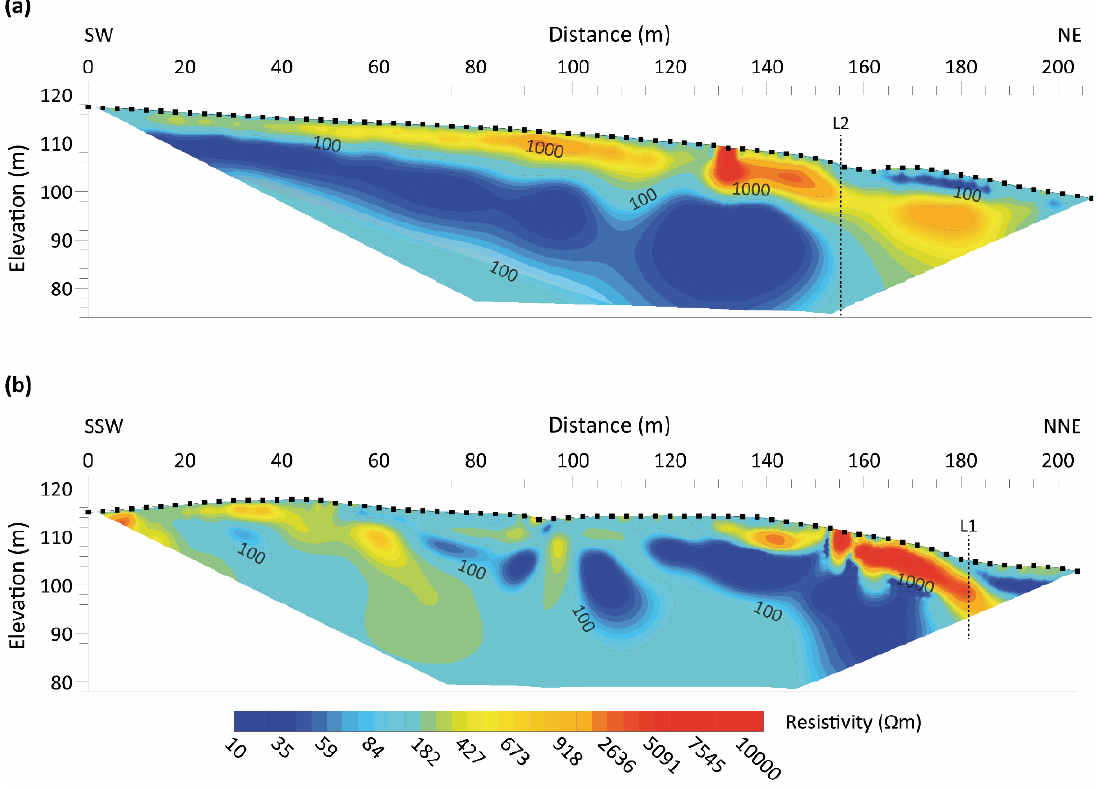
Figure 4. Electrical resistivity tomography profiles. ( a ) Line 1; ( b ) Line 2. Locations are shown in Figure 1.